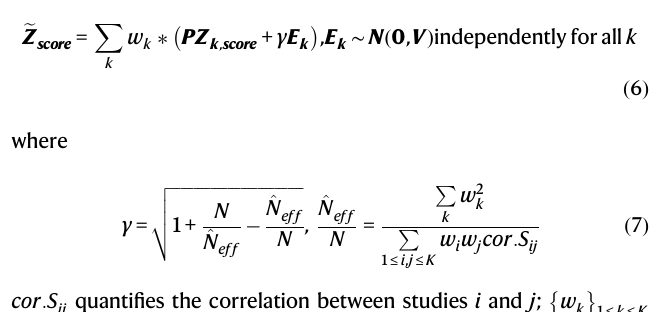
inference using individual level data. We present the approach based on marginal test statistics. C The proposed GhostKnockoff using Z-scores from conventional GWAS as